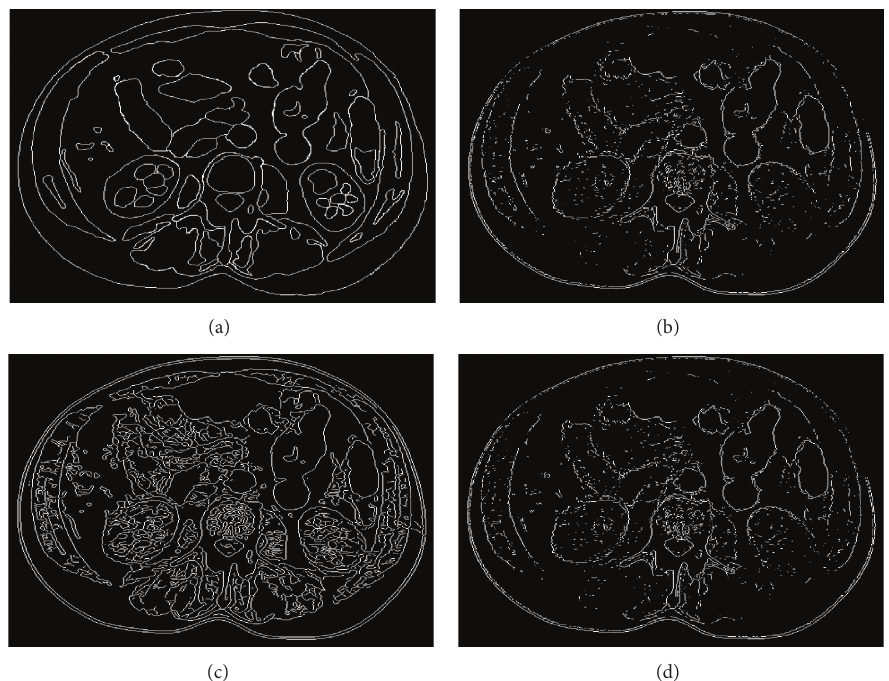
Figure 8: Edges of Figure 5(a); (a) manually drawn ground truth edge, (b) Prewitt, (c) Canny, and (d) Sobel.